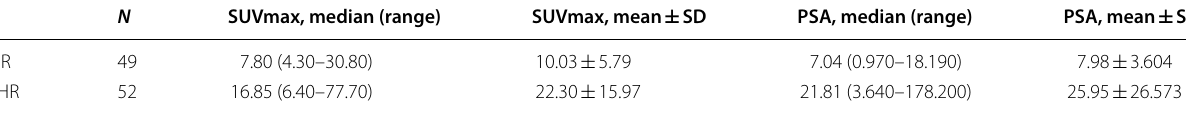
Table 2 SUVmax value and PSA level of the primary tumor in different risk groups